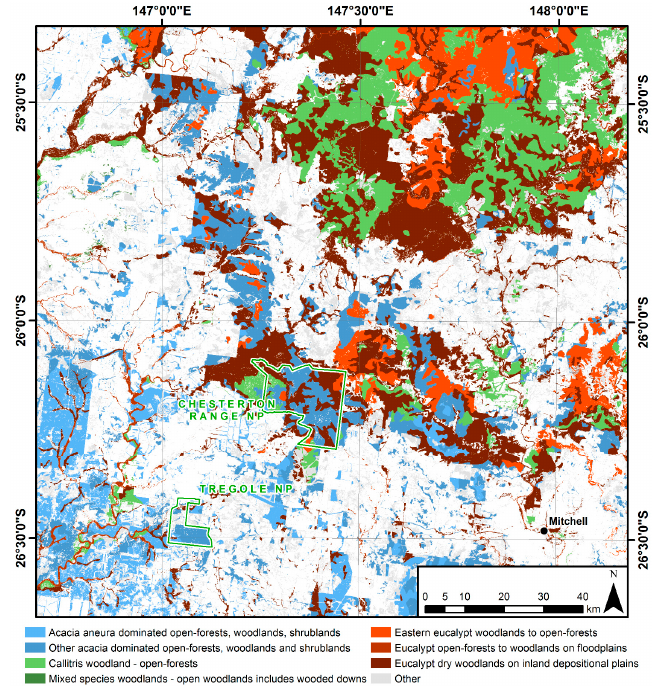
Figure 2. Broad vegetation groups of the forested study area (Regional Ecosystem Mapping of 2006 [30]). The analysis was restricted to the forested areas (colors); the “other” class was compiled using